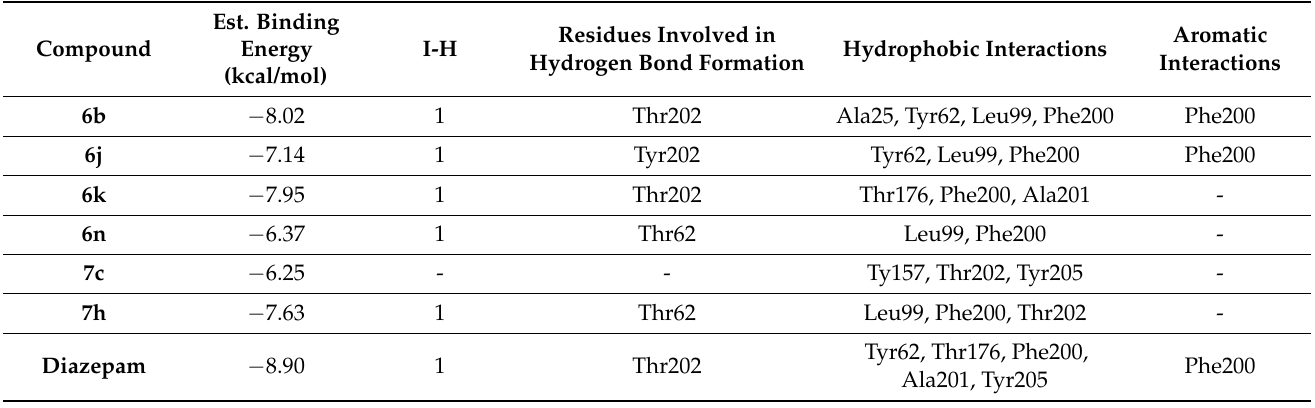
Table 7. Molecular docking scoring function that estimates free energy of binding (kcal/mol) into GABA A receptor (PDB code: